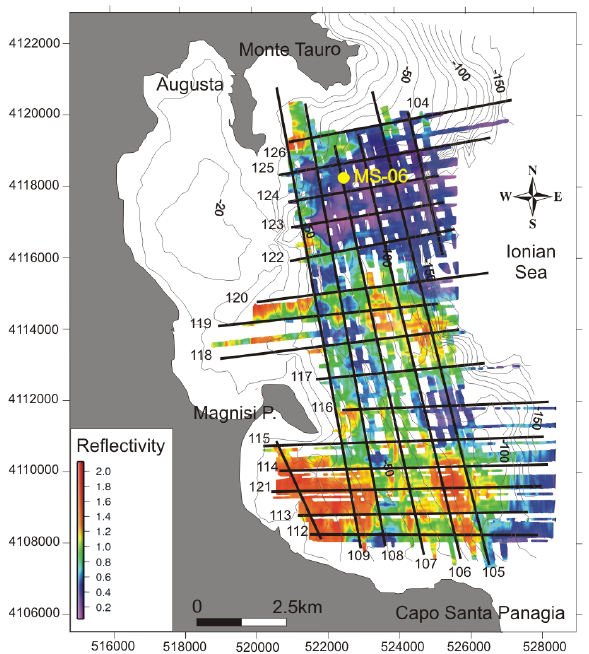
Figure 3. Chirp sub-bottom seismic profile grid (numbered black lines) and reflectivity map of the Augusta Basin, colour scale indi- cates different reflectivity values; yellow dot shows location of the long sediment gravity core (MS-06) by Smedile et al.